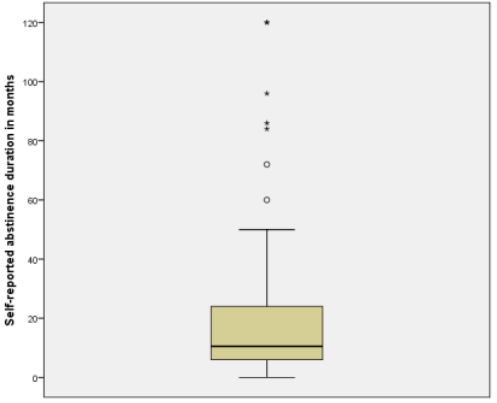
Figure 1. Box-plot showing self-reported abstinence duration (in months).